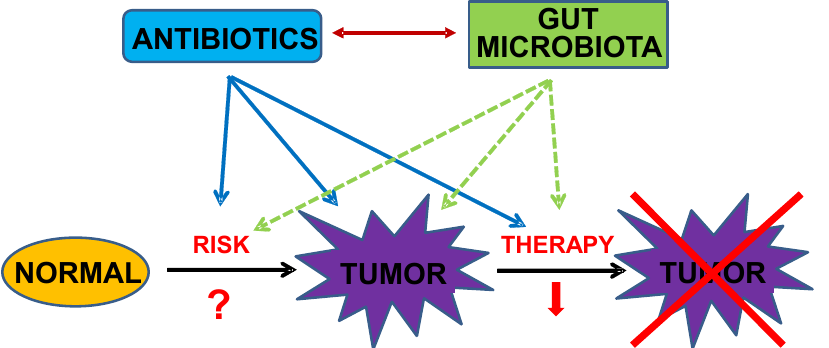
Figure 2. Diagram showing the interactions between antibiotic exposure and the human gut microbiota, and the possible effects of their cross-talk on the risk of cancer development and the response to therapy are indicated by arrows.